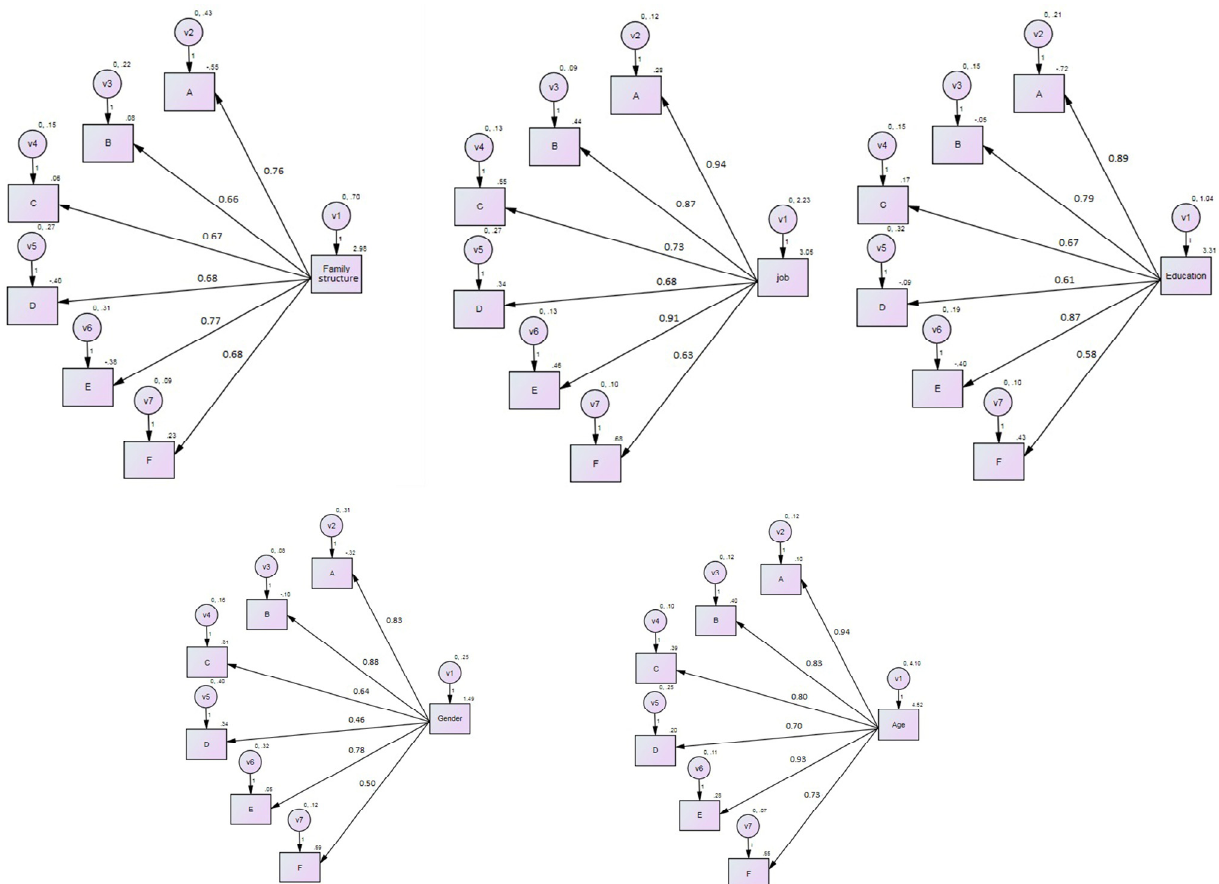
Figure 3. Structural results for the impacts of sociodemographic characteristics on TBCs.